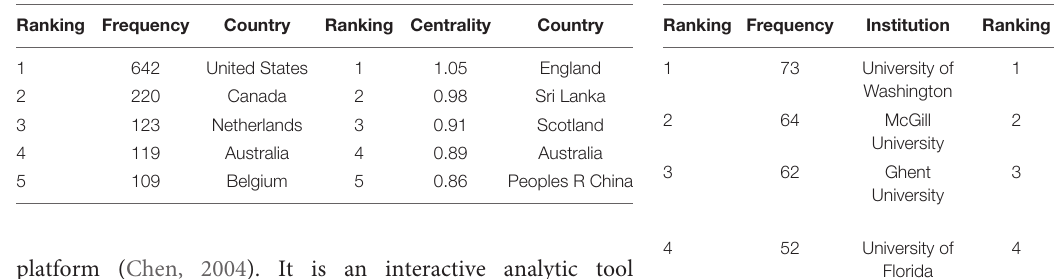
TABLE 4 | The top five institutions related to pain catastrophizing. Ranking Frequency